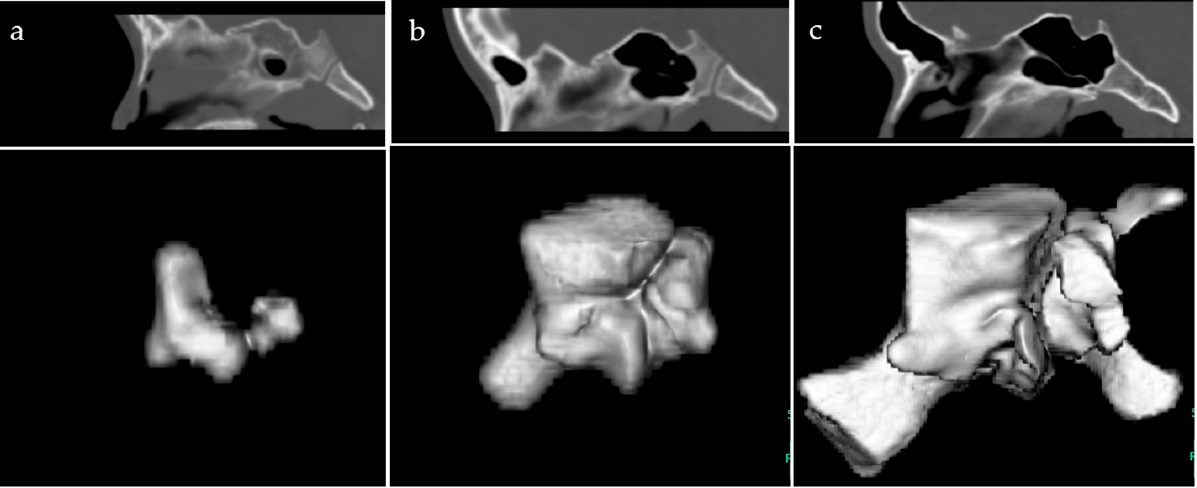
Figure 1. Representative images of the sphenoid sinus. ( a ) Presellar; ( b ) sellar; ( c ) postsellar.